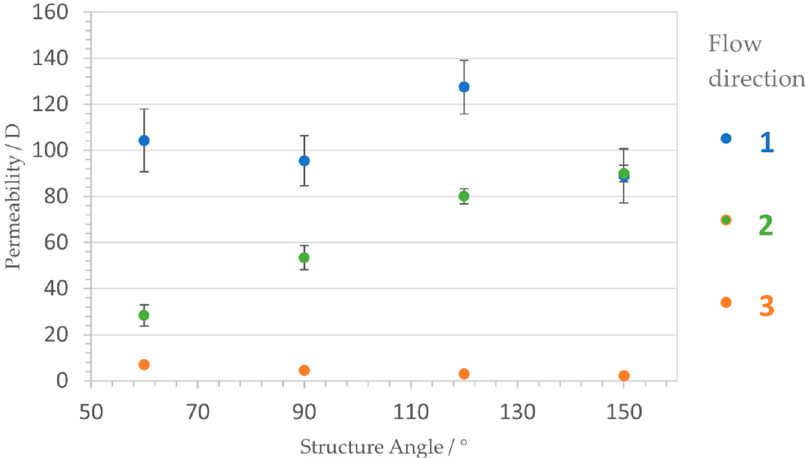
Figure 12. Correlation between permeability K and structure angle α , depicted in dependence of the dimensional orientation. Blue dots, unhindered orientation; green dots, angle dependent orientation; orange dots, blocked flow orientation.